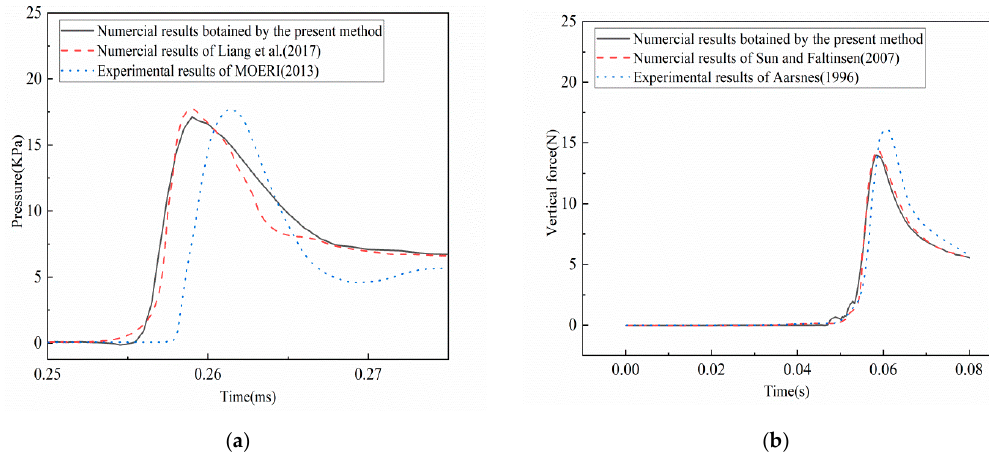
Figure 11. Contrastive results for the water entry of MOERI’s bow-flared section: ( a ) P8; ( b ) P9.